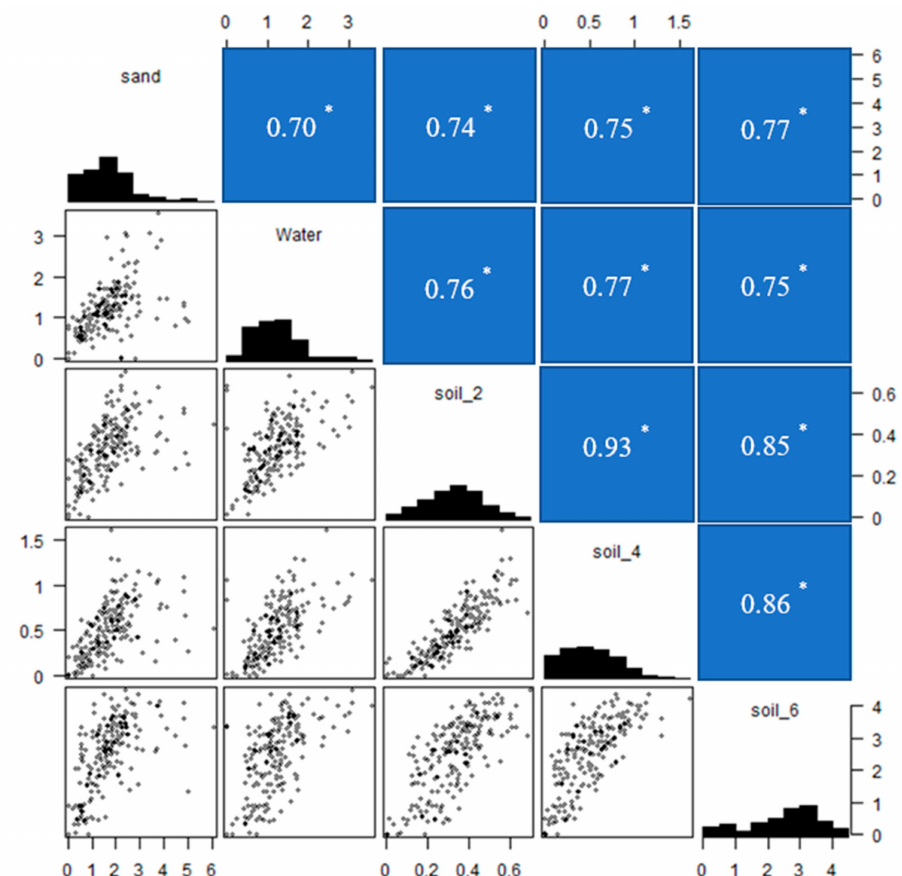
Figure 1. Summary of the phenotypic variations of mesocotyl length among di ff erent culture conditions, including correlations between mesocotyl lengths under di ff erent culture conditions and mesocotyl length distribution under varied culture conditions. Soil_2: soil culture with 2 cm sowing depth; Soil_4: soil culture with 4 cm sowing depth; Soil_6: soil culture with 6 cm sowing depth, numbers in blue boxes are correlation coe ffi cients ( r ), * indicates the significance at p ≤